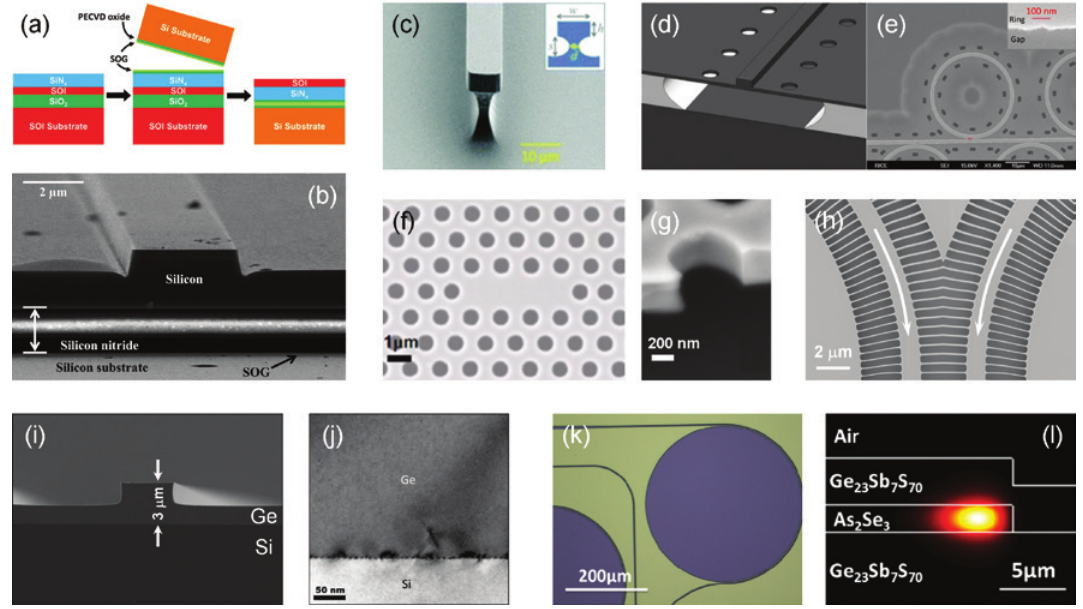
Figure 3: Examples of passive mid-IR photonic platforms. (A, B) silicon-on-nitride [10] (© 2013 AIP Publishing LLC): (A) schematic fabrication process flow and (B) SEM tilted view of silicon-on-nitride mid-IR waveguides. (C–H) Pedestal or suspended Si devices: (C) SEM image of a pedestal mid-IR silicon waveguide. Reprinted with permis- sion from [11], (D, E) schematic view and top-view SEM image of suspended Si mid-IR micro-ring resonators [12] (© 2013 Optical Society of America), the waveguides assume a ridge geometry and an undercut etch removes the silicon dioxide cladding through access holes on the slab layer, (F, G) SEM micrographs of a suspended mid-IR Si photonic crystal cavity [13] (© 2011 Optical Society of America), (H) suspended mid-IR Si waveguides with sub-wavelength grating (SWG) claddings [14] (© 2016 Optical Society of America); here the SWG provides both lateral optical confinement as well as access to the oxide under cladding during wet etch structure release; the arrows indicate light propagation direction in the suspended core. (I, J) Ge-on-Si [15] (© 2015 IEEE): (I) a mid-IR Ge-on-Si ridge waveguide; (J) TEM cross-sectional image of the Ge-on-Si film showing that the dislocations are confined at the Si/Ge interface. (K, L) Chalcogenide glass-on-silicon [16] (© 2013 Optical Society of America): (K) top-view optical micrograph of a ChG micro-disk resonator, (L) cross-sectional structure and simu- lated whispering gallery mode profile in the micro-disk at 5.2- μ m wavelength; the high-index As by low-index Ge Sb S glass 23 7 70